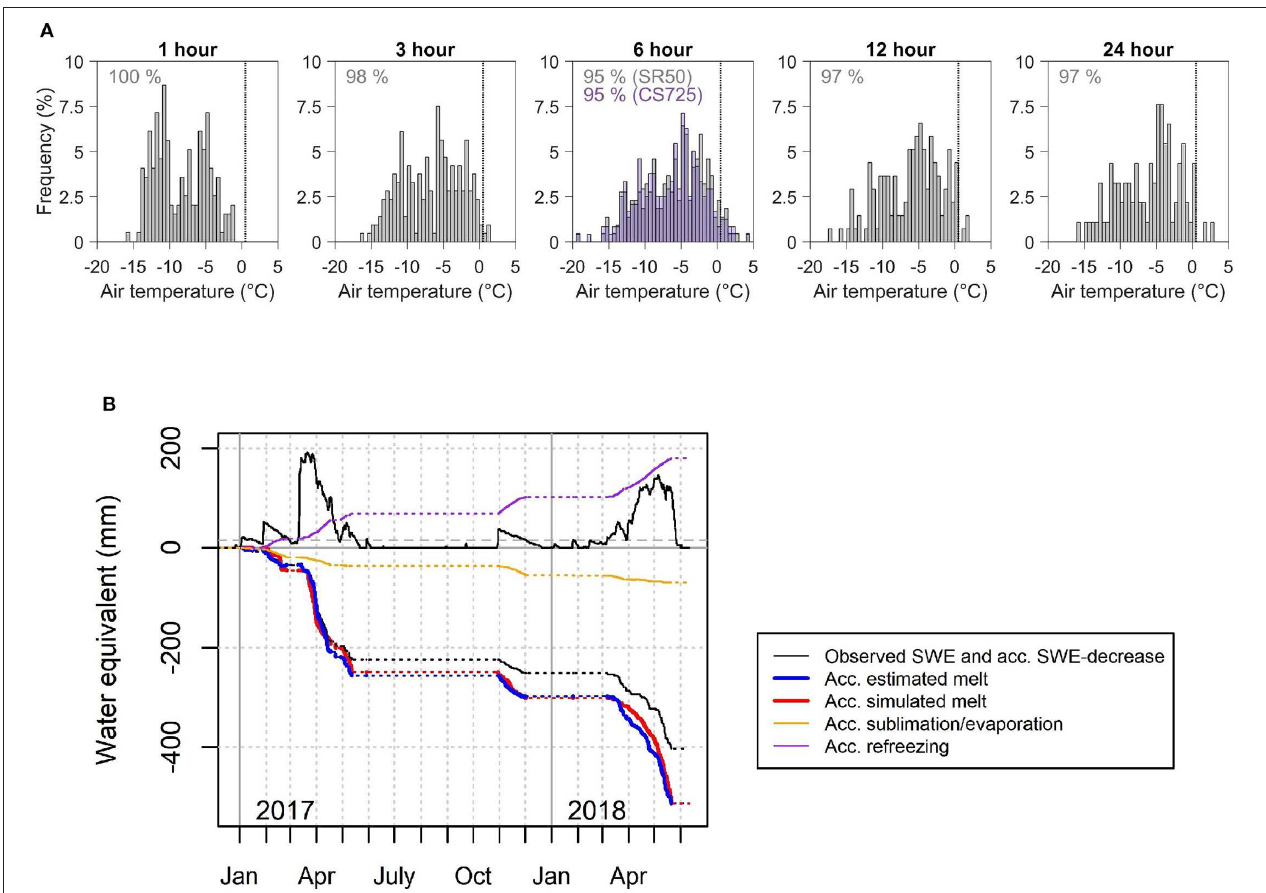
FIGURE 3 | (A) Frequency distribution of ambient air temperatures at which snowfall occurs at the Ganja La station. The percentage of snow events that occur below the 0.5 ◦ C model temperature threshold is stated for 1, 3, 6, 12, and 24-h time windows. (B) Observed SWE and its accumulated (negative values) decrease at the Ganja La station (black lines) as well as the estimated ( M obs ; blue line) and simulated ( M eDD ; red line) accumulated snow melt during the snow-covered period in 2017–2018. The estimated accumulated sublimation/evaporation (orange line) and refreezing of melt water (purple line) are also shown. The gray dashed line denotes the lower limit of 15mm SWE used in definition of the snow-covered period ( t SCP